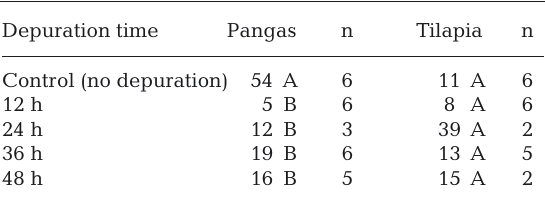
Table 3. Mean concentrations (least squares, from ANOVA) of geosmin (ng kg −1 wet weight) in meat from fish from ponds with different depuration times. For each species, depuration times not marked with the same letter are significantly different (p < 0.05). n: number of analyzed